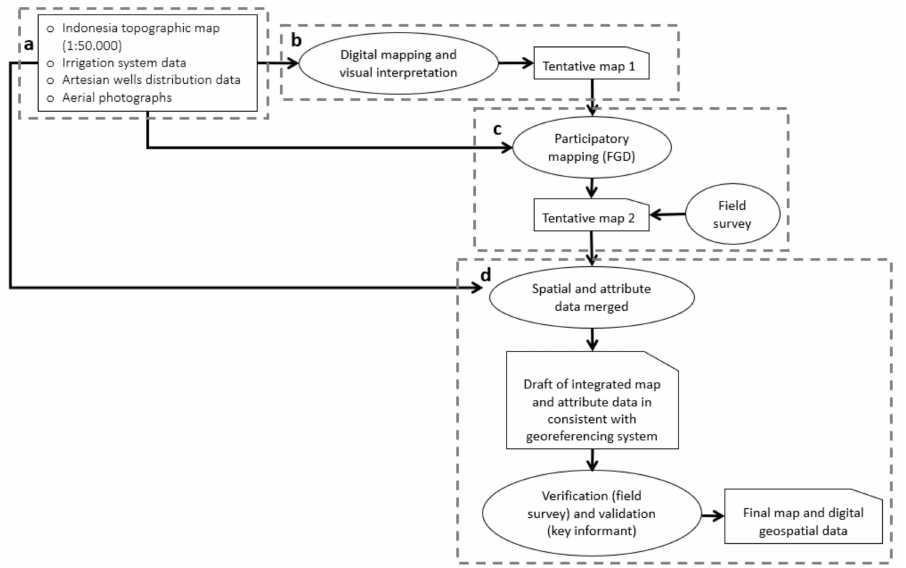
Figure 6. The workflow of participatory mapping scaled 2D mapping